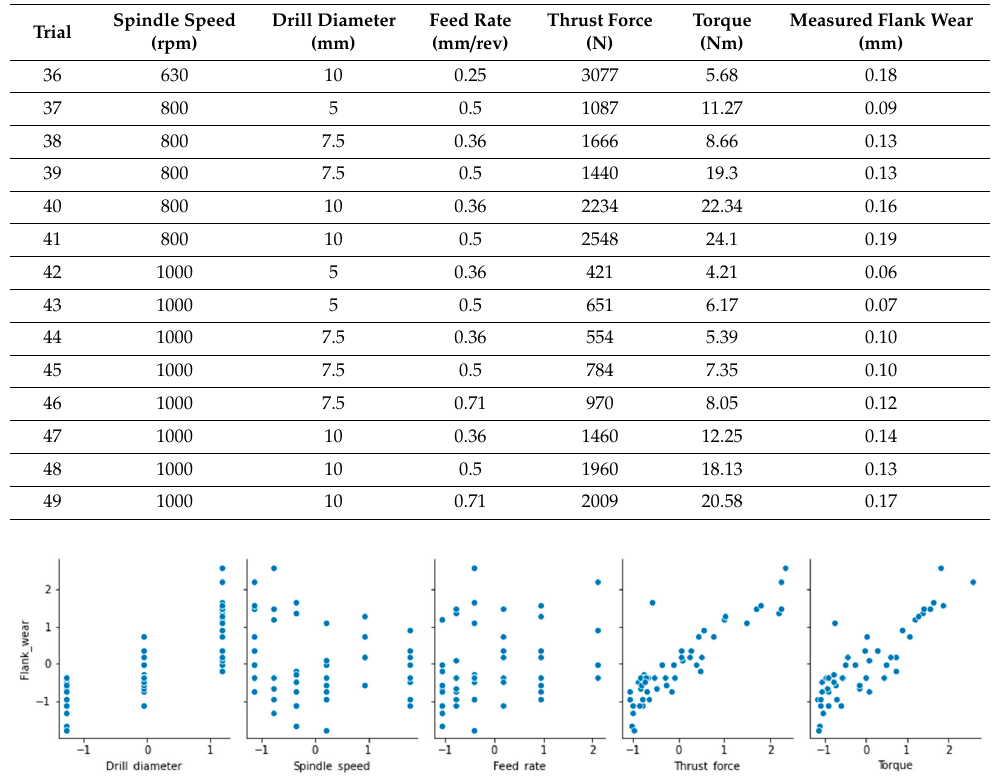
Figure 2. Pairwise relationship of different inputs with the flank wear of the copper workpiece.